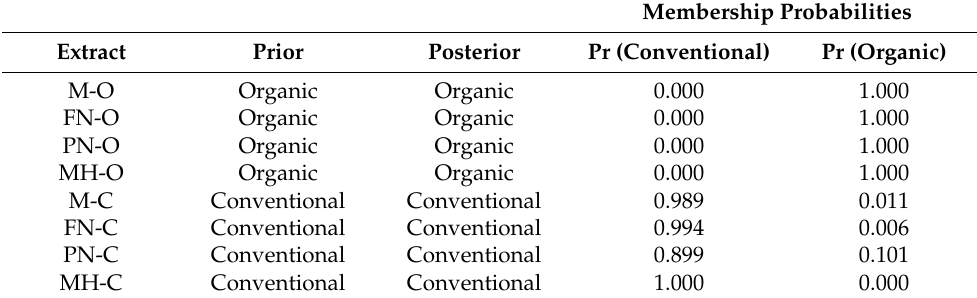
Table 7. Prior and posterior classification of the red grape seeds extracts using PC-DA (Raman spectral